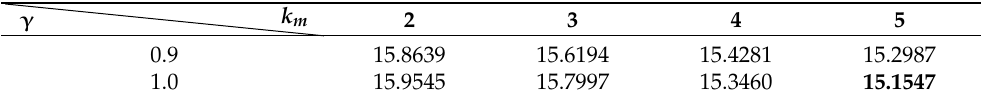
Table 7. AREs of predicted